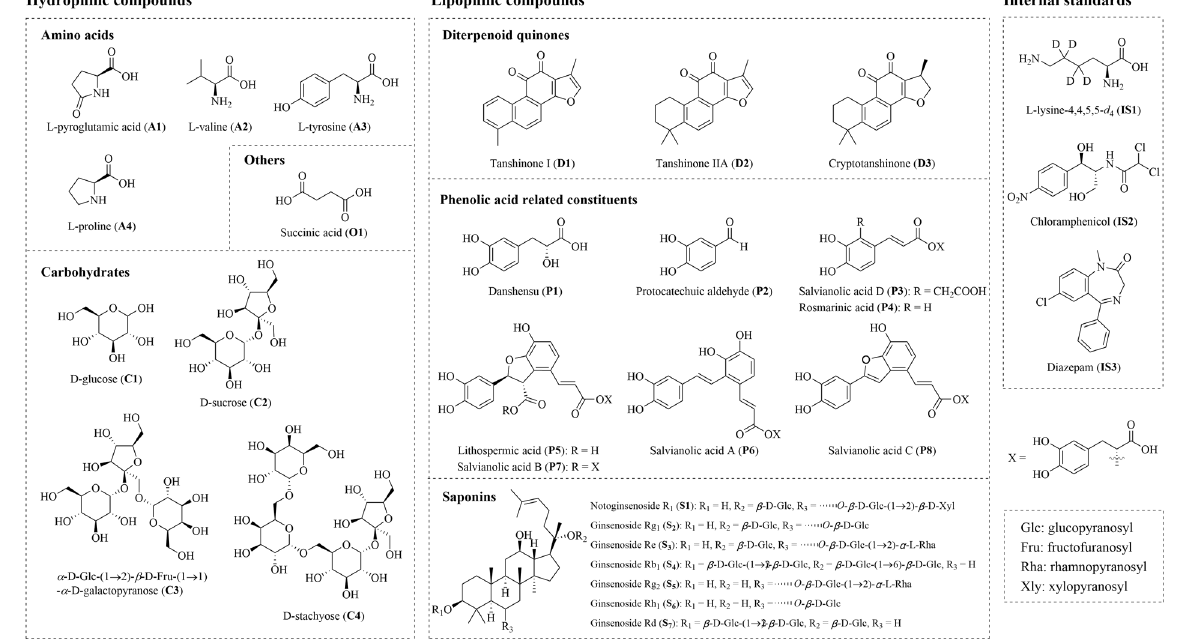
Figure 1. Structures of 27 analytes and 3 internal